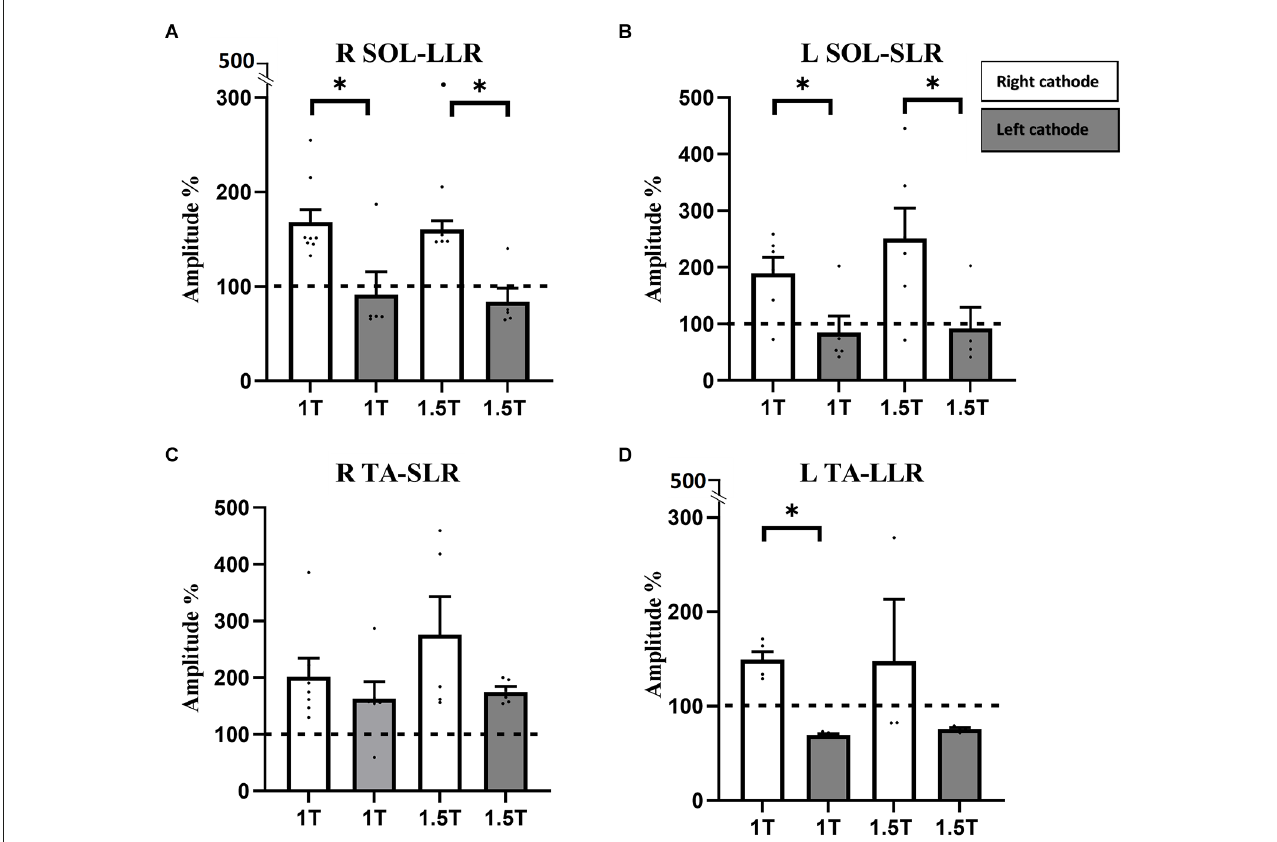
FIGURE3 Responses in RSOL (A) , LSOL (B) , and L TA (D) were polarity dependent, but not statistically different between 1 and 1.5 T. Responses in R TA (C) were not polarity dependent. RSOL, right soleus; LSOL, left soleus; L TA, left tibialis anterior muscles; R TA, tibialis anterior muscles. Statistical significance is shown with an asterisk ( ∗